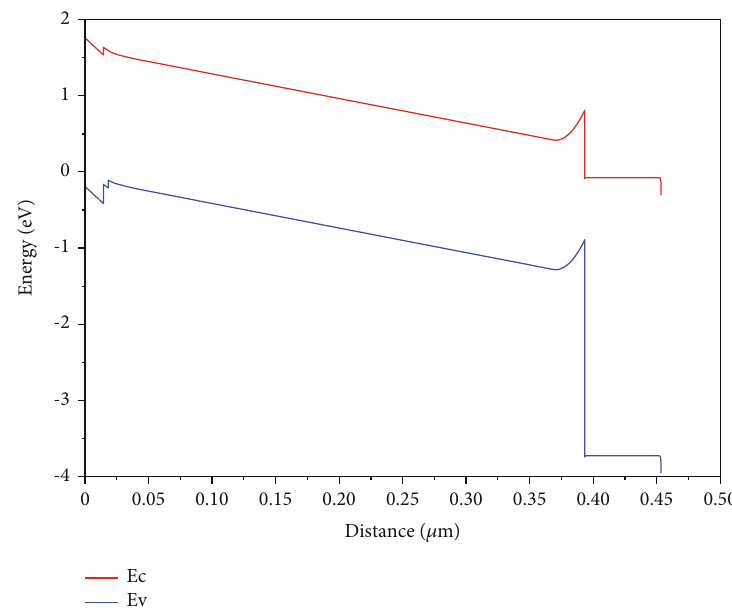
Figure 3: Energy band diagram of p -(a-SiO